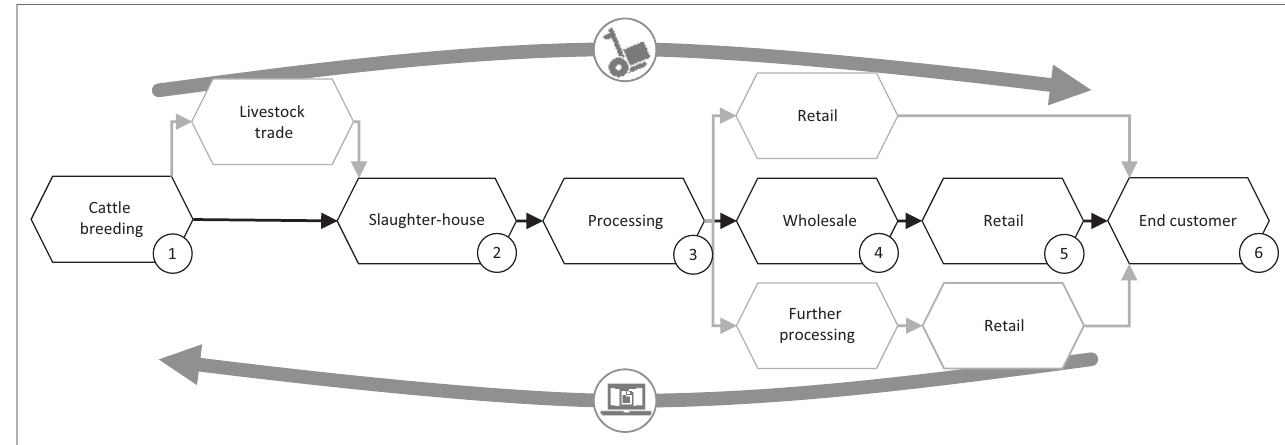
FIGURE 1: Simplified SC of beef steak – network level structure.